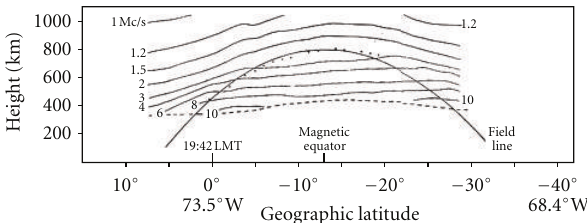
Figure 6: Contours of constant electron density at 19:42 LT. Points show the height of the ledge according to one Alouette-1 satellite path (from Lockwood and Nelms [18]). The dashed line is the height of the F2 layer peak.